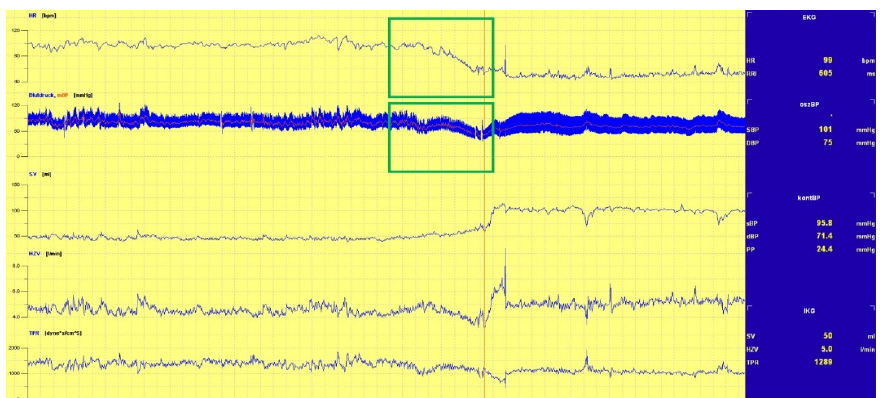
Figure 4. Continuous Drop in BP. 3.1.1. Head-Up Tilt (HUT) Test A footplate-supported table equipped with an automatic tilting mechanism was used for the HUT test. Before the tilting of the table, patients were observed in a supine position for ten minutes. The flat-top bedding surface containing safety straps was then tilted to the angles of 60° to 80° in a quick span of time. The rationale behind the whole action is that a sudden change in posture sometimes induces vasovagal syncope, which is charac- terized by a sudden drop in HR and BP [17]. Constant monitoring of electrocardiographic signals, along with continuous beat-to-beat checking of BP, was performed during the test. The data were collected using the Task Force Monitor (CNSystems, Graz, Austria). All data obtained were obtained from each of the 3 positions: supine–HUT–return to su- pine and then the data were averaged. Systolic blood pressure and diastolic blood pres- sure were measured at the right brachial artery using the oscillometric method. Hemody- namic parameters such as stroke volume (SV), cardiac output, total peripheral resistance were recorded beat-to-beat using impedance cardiography [18–20]. Total peripheral re- sistance was calculated from the CO and BP values measured with a finger sensor; auto- matic calibration was performed using the oscillometric method. Heart rate measure- ments were carried out using RR-interval. Presyncope is the state immediately preceding a syncopal event, defined as a sudden, brief, transient loss of consciousness [21–23]. ‘Physiological’ syncope during orthostatic loading develops as the result of critically diminished cardiac preload due to low venous return. Once the brain perfusion is reduced to below a critical level, a “vasovagal attack”